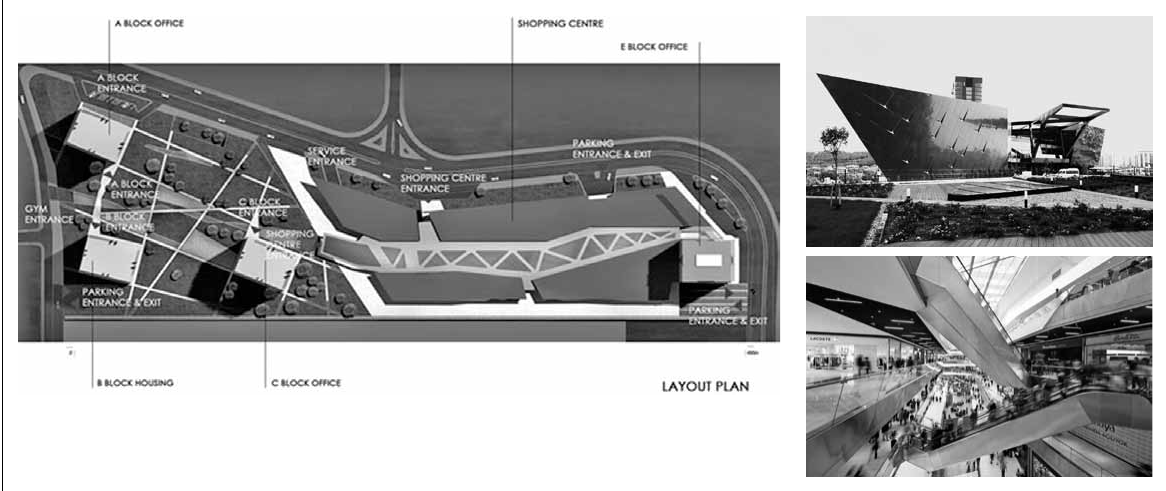
fig. 8. Buyaka Shopping Mall Plan-Exterior-Interior,